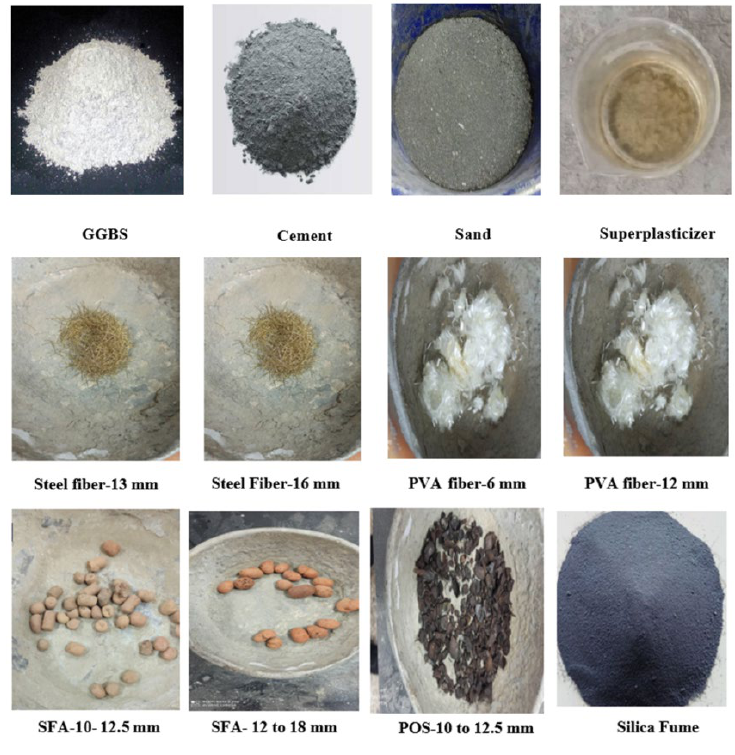
Figure 1. Raw materials.